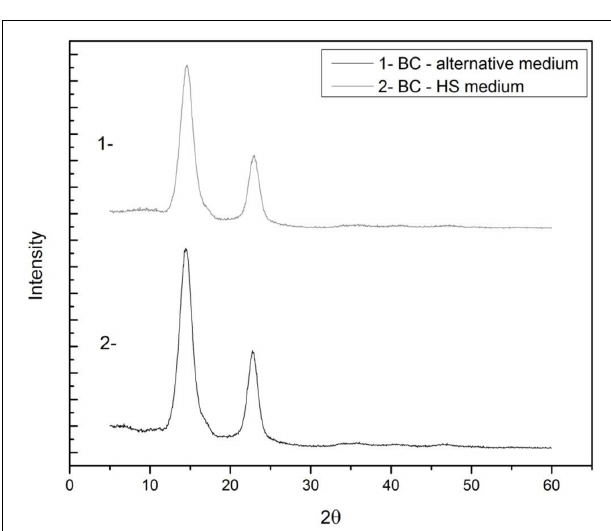
FIGURE 4 | X-ray diffraction diagrams of BC dried pellicles obtained after 10 days of fermentation in Hestrin–Schramm (HS) medium (2% glucose, 0.5% yeast extract, 0.5% peptone, 0.27% Na 2 HPO 4 , and 1.5% citric acid) and in the alternative medium formulated with 1.5% glucose, 2.5% CSL, 0.27% Na 2 HPO 4 , and 1.5% citric